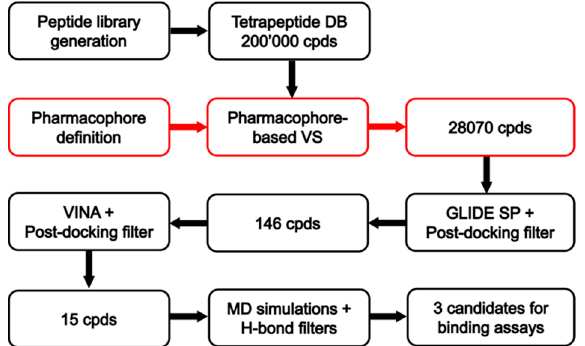
Figure 2. Schematic workflow of the receptor-based virtual screening (VS).